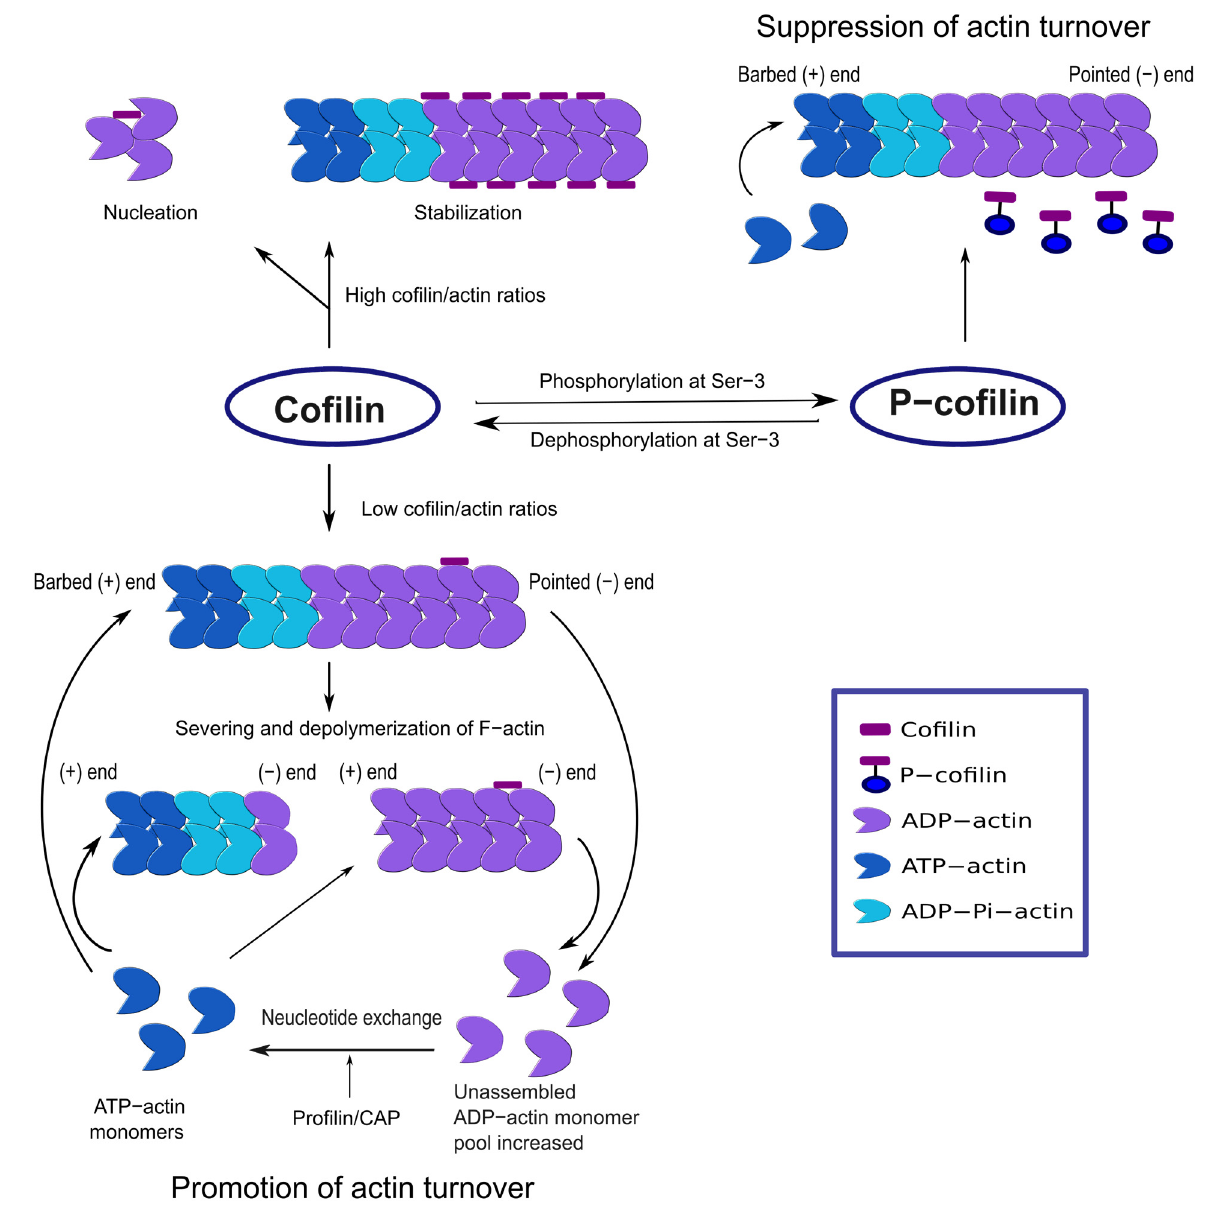
Figure 1. Actin dynamics regulation by cofilin. At low cofilin/actin ratios, cofilin severs F-actin and increases the ADP-actin monomer dissociation rate. Actin polymerization is favored in the presence of nucleotide exchange regulators (e.g., profilin, CAP). At high cofilin/actin ratios, cofilin stabilizes F-actin where all the subunits have undergone cofilin-induced rotation. Cofilin can also induce nucleation. Inactive p-cofilin does not significantly bind to F-actin, and actin severing or depolymerization is low.